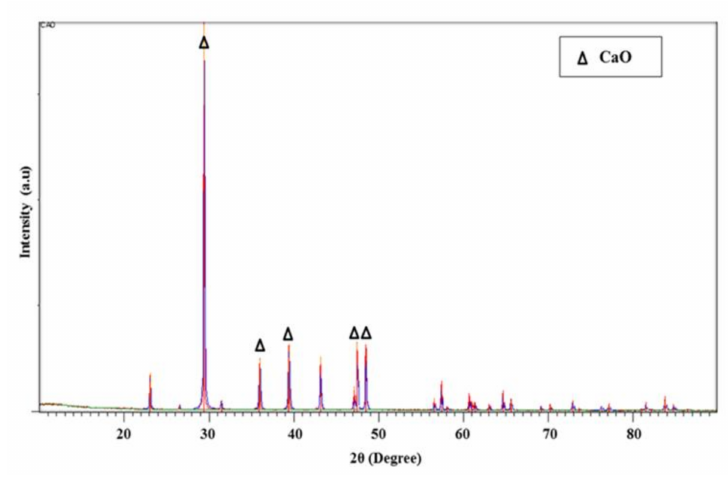
Figure 11. XRD analysis of CaO.